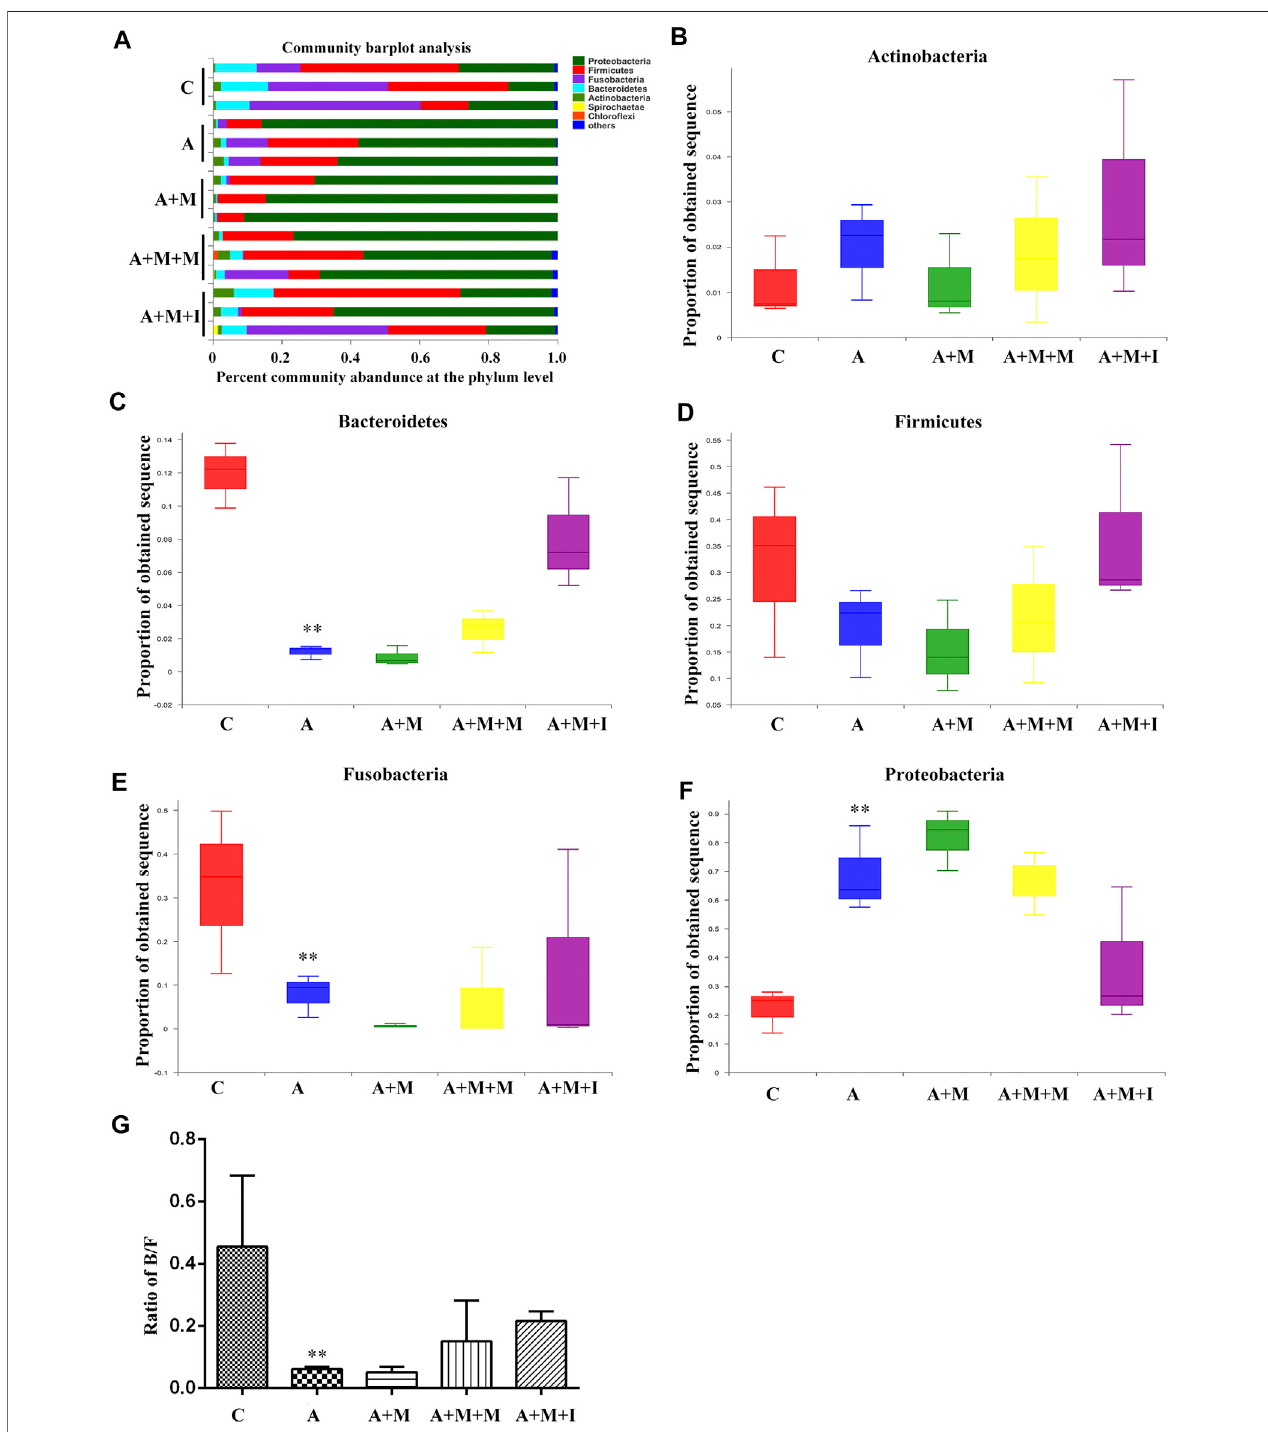
FIGURE 12 | Comparison of species composition among the fecal microbiota of the C, A, A + M, A + M + M, and A + M + I groups at the phylum level. (A) Relative abundances ofthephylapresent in samplesfrom the fi ve groups. Percentof (B) Actinobacteria abundance (C) Bacteroidetes abundance (D) Firmicutes abundance (E) Fusobacteria abundance, and (F) Proteobacteria abundance at the phylum level among the fi ve groups. (G) The Bacteroidetes/Firmicutes (B/F) ratio of the fi ve groups. * p < 0.05, ** p < 0.01 vs the C group; # p < 0.05, ## p < 0.01 vs the A + M group; ▲ p < 0.05, ▲▲ p < 0.01 vs the A group. C: control group; A: antibiotic group; A + M: antibiotic + morphine group; A + M + M: antibiotic + morphine + methadone group; A + M + I: antibiotic + morphine + isorhynchophylline group.